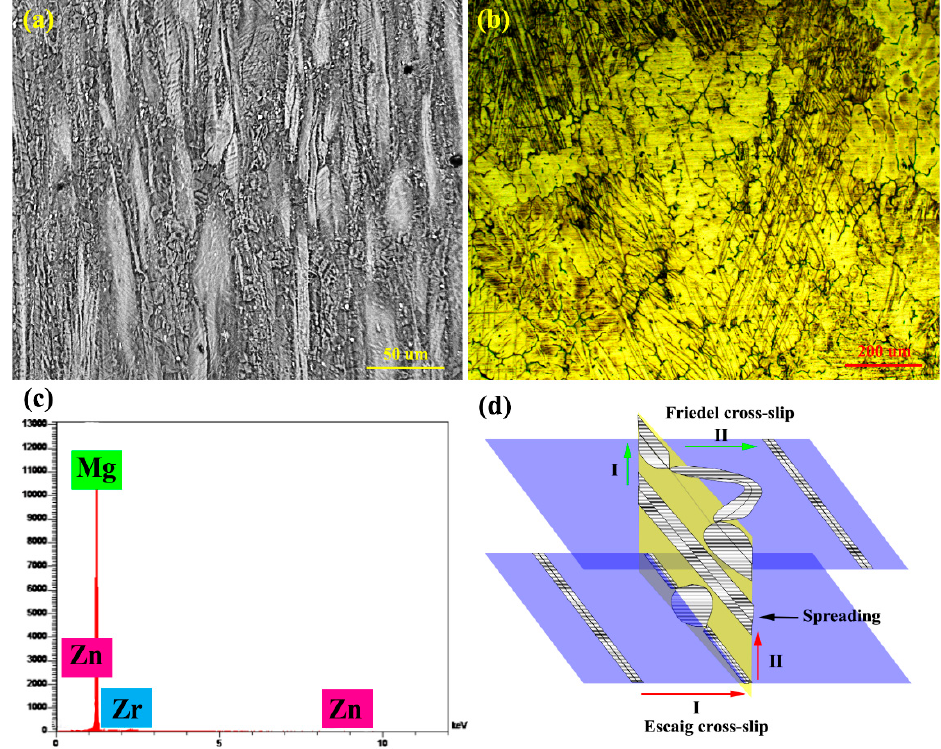
Figure 10. ( a , c ) SEM micrograph and EDS analysis, ( b ) OM micrograph after creep at 150 °C under 100 MPa stress, and ( d ) schematic of the DFE mechanism.